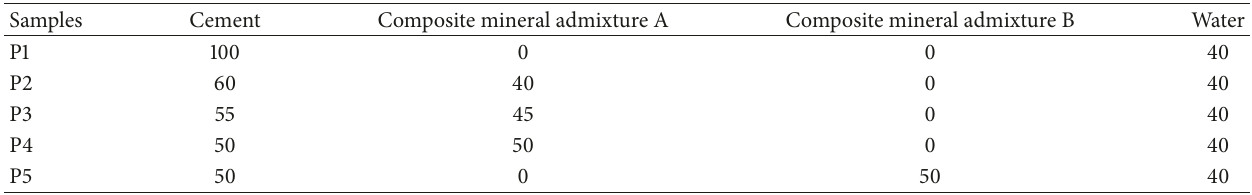
Table 2: Mixing proportions for the composite binders used for hydration heat evolution (g).